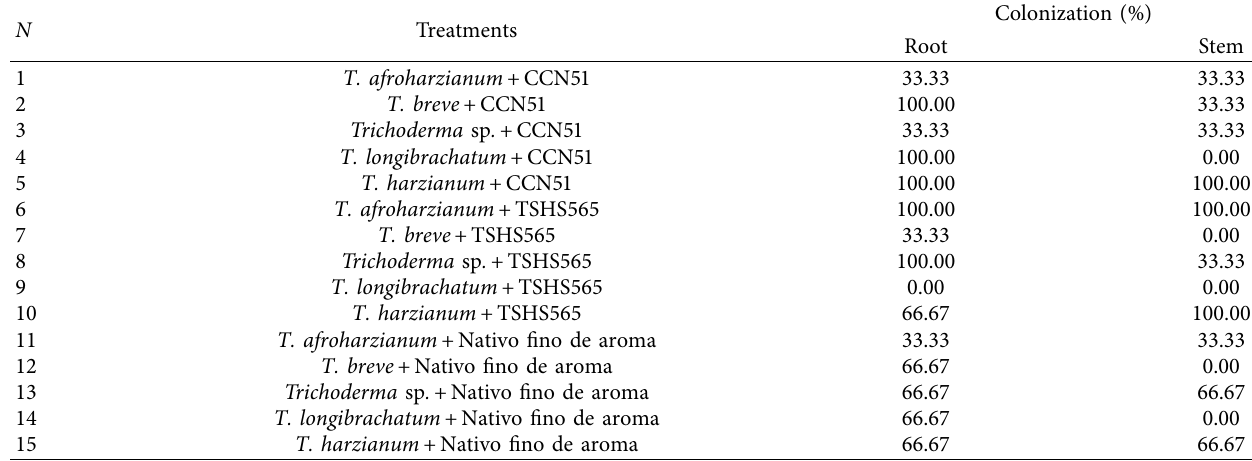
Table 3: Extent of Trichoderma colonization in the roots and stems of cocoa.